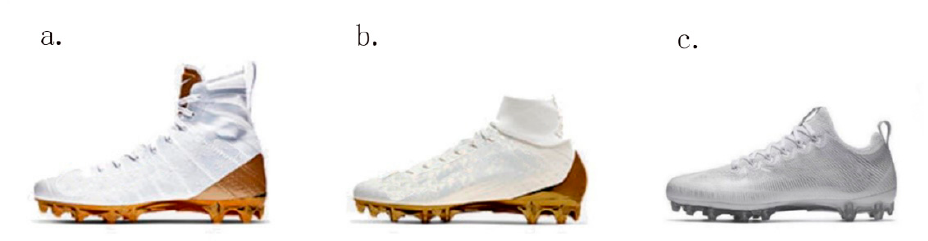
Figure 1. Football shoes used in the current study. ( a ) high collar shoe, ( b ) elastic collar shoe, ( c ) low collar shoe.